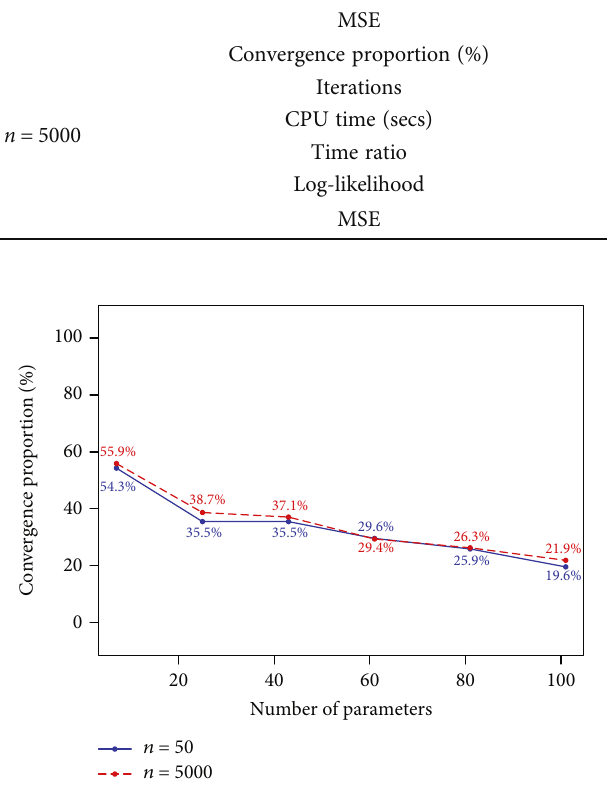
Figure 1: Convergence proportions for